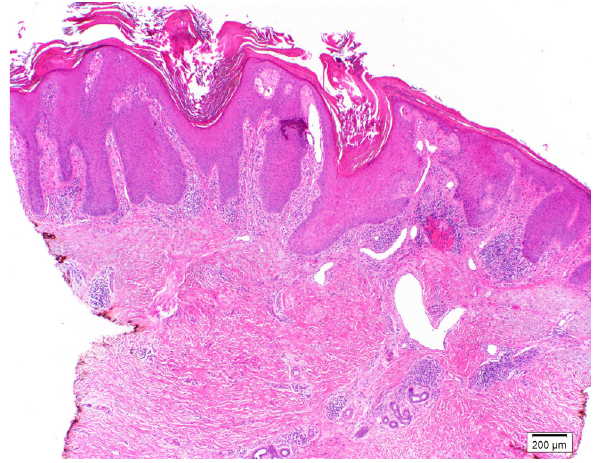
Figure 2. Histological photo of hypertrophic lupus erythematosus. Hypertrophic lupus erythematosus displays epidermal acanthosis and expansion of follicular ostia with a superficial and deep perivascular and periappendageal intradermal lymphocytic infiltrate (hematoxylin and eosin, 40× magnification).